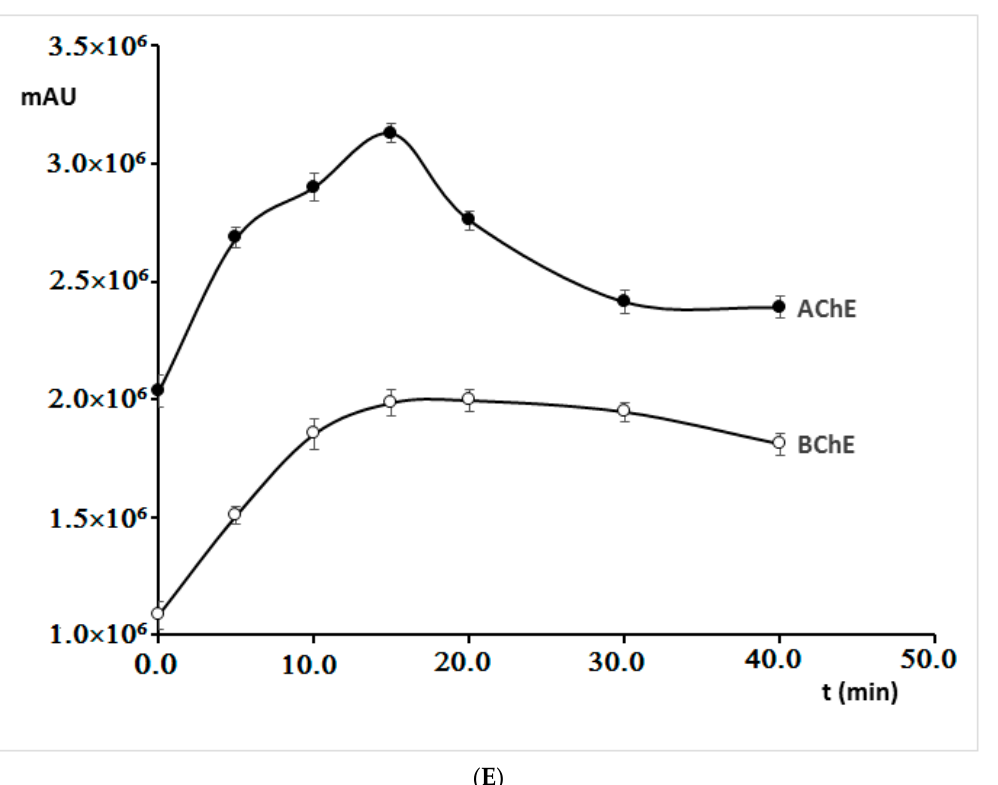
Figure 3. ( A ) Dependence of concentration of cholinesterases on the peak area. Error bars represent standard errors. ( B ) Dependence of ACTI and BCTI concentrations in the reaction with cholinesterases on the peak area. Error bars represent standard errors. ( C ) Dependence of the DTNB concentration in reaction with cholinesterases on the peak area. Error bars represent standard errors. ( D ) Dependence of the temperature of incubation in reaction with cholinesterases on the peak area. Error bars represent standard errors. ( E ) Dependence of the incubation time in reaction with acetylcholinesterases on the peak area. Error bars represent standard